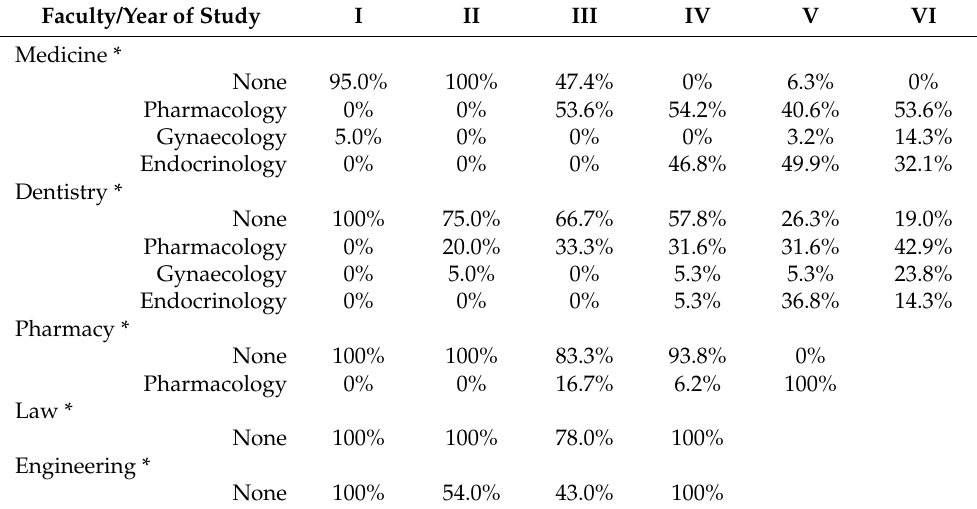
Table 2. Distribution of information on the benefit/risk ratio of oral contraceptive treatment by courses (Answers to the question: “Please indicate which courses have provided you information about oral contraceptive